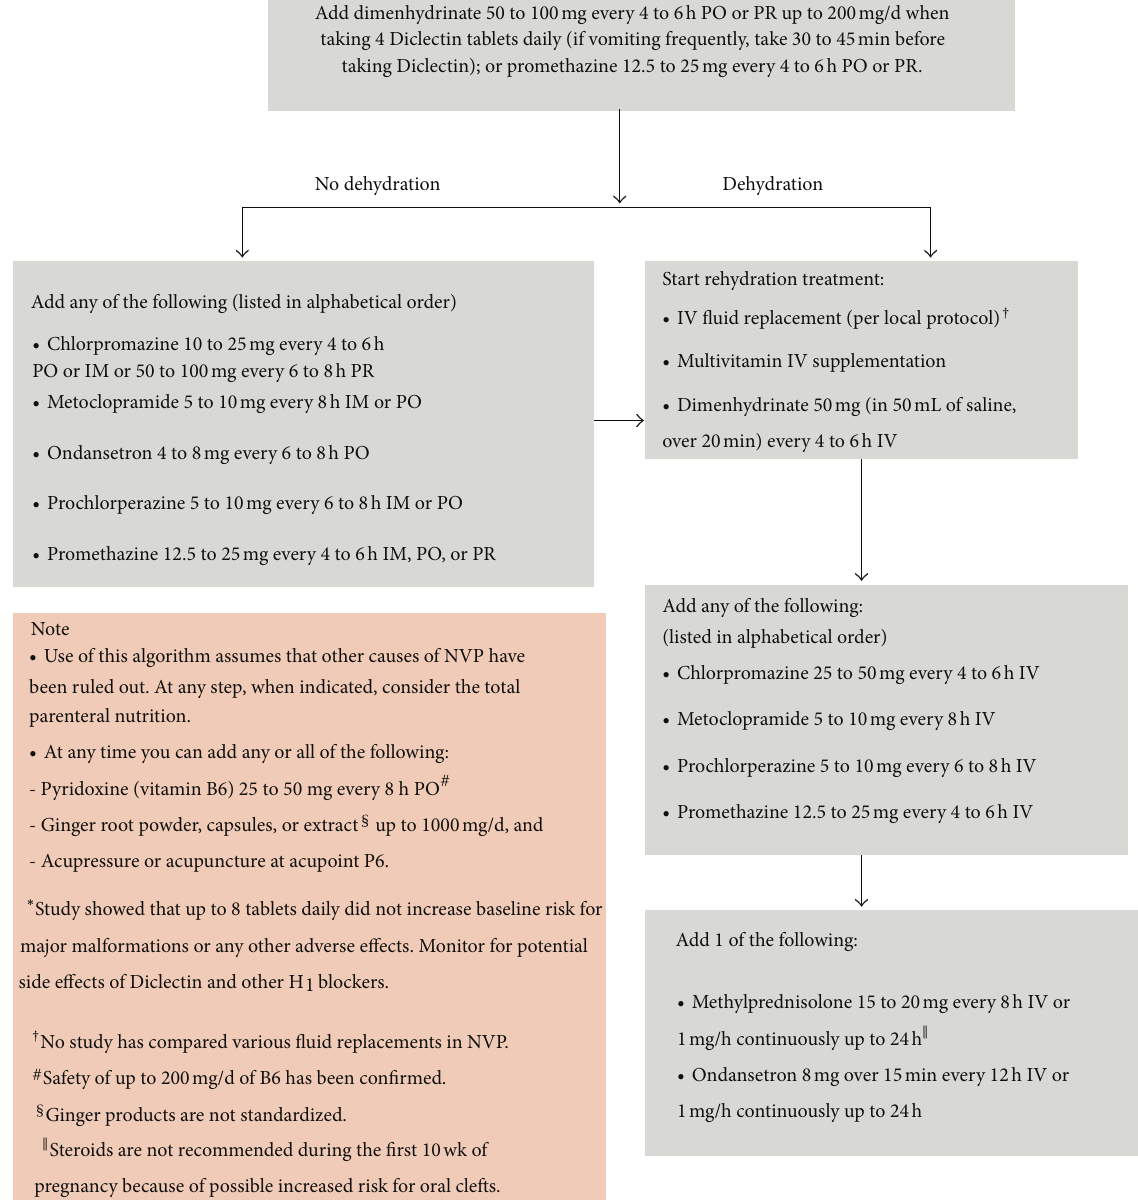
Figure 1: Motherisk NVP algorithm [2–4,